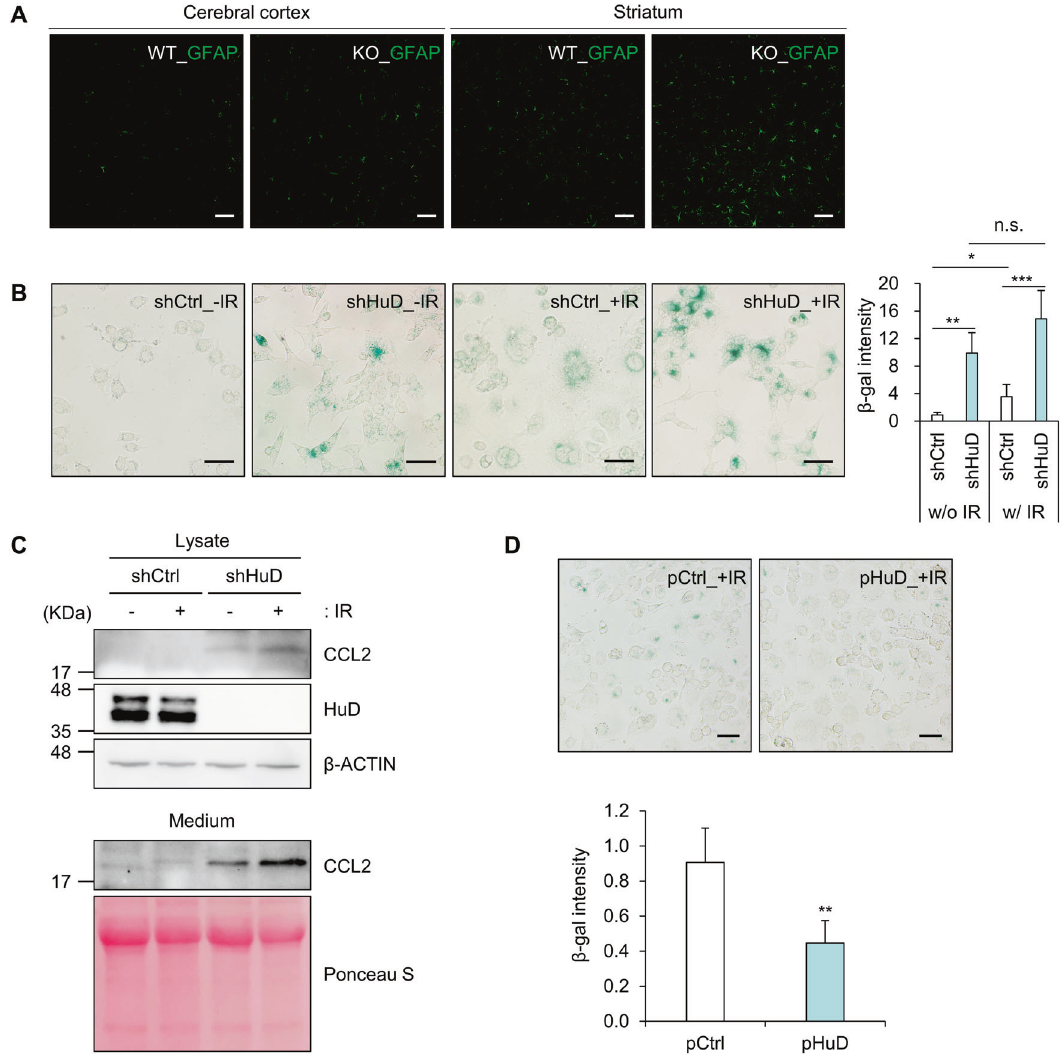
Fig. 5 Sensitization of N2a cells via HuD knockdown in response to senescence inducer. A Relative level of GFAP, an astrocyte marker, was analyzed in the cerebral cortex and striatum regions in the brain of HuD KO mice and their age-matched control mice by immuno fl uorescence microscopy. n = 3. B , C After exposure to γ -irradiation (5.5 Gy), the levels of SA β -gal ( B ) and CCL2 expression ( C ) were analyzed by β -gal staining and western blotting analysis. D N2a cells were transiently transfected with plasmids and exposed to γ -irradiation. The levels of SA β -gal were assessed by β -gal staining and densitometric analysis using Image J. Scale bar, 50 μ m. Images are representative, and data indicate the mean ± SEM derived from three independent experiments. The statistical signi fi cance of the data was analyzed via Student ’ s t -test; * p